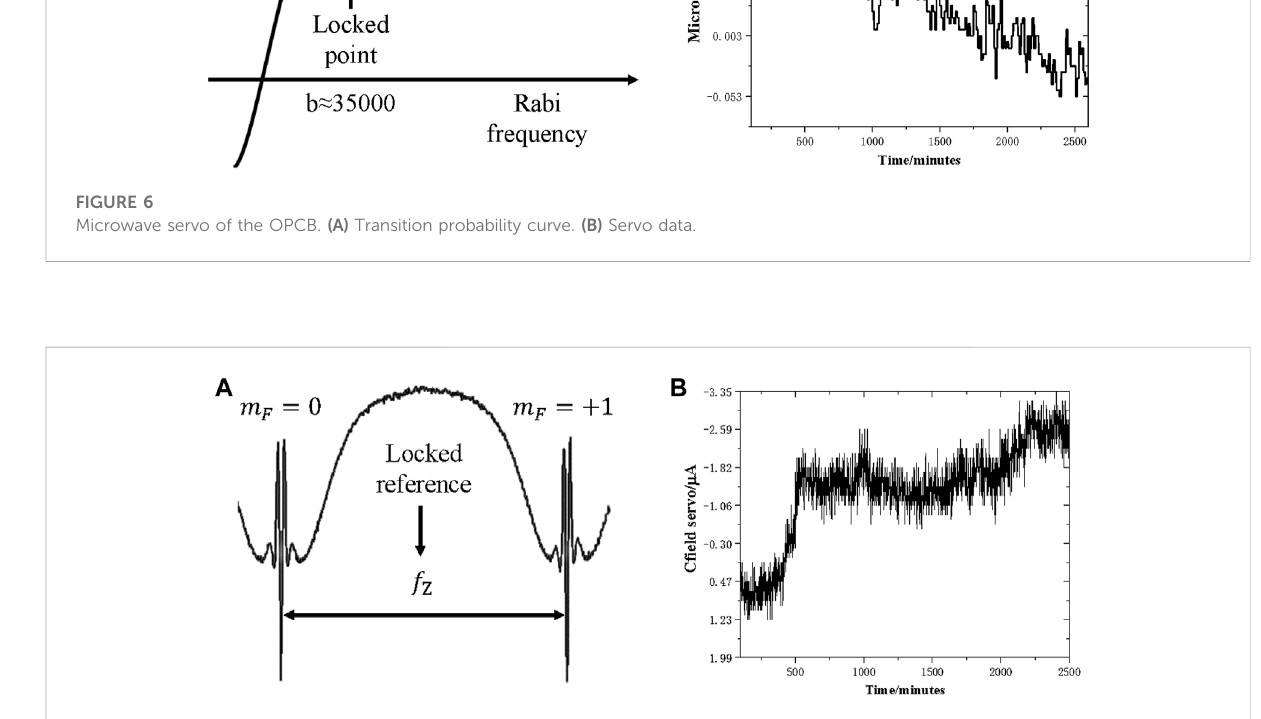
C- fi eld servo of the OPCB. (A) Zeeman frequency as the locked reference. (B) Servo